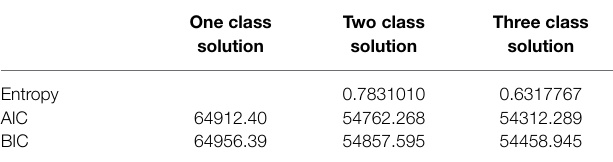
TABLE 2 | Goodness-of-fit statistics of the competing latent class analysis models.